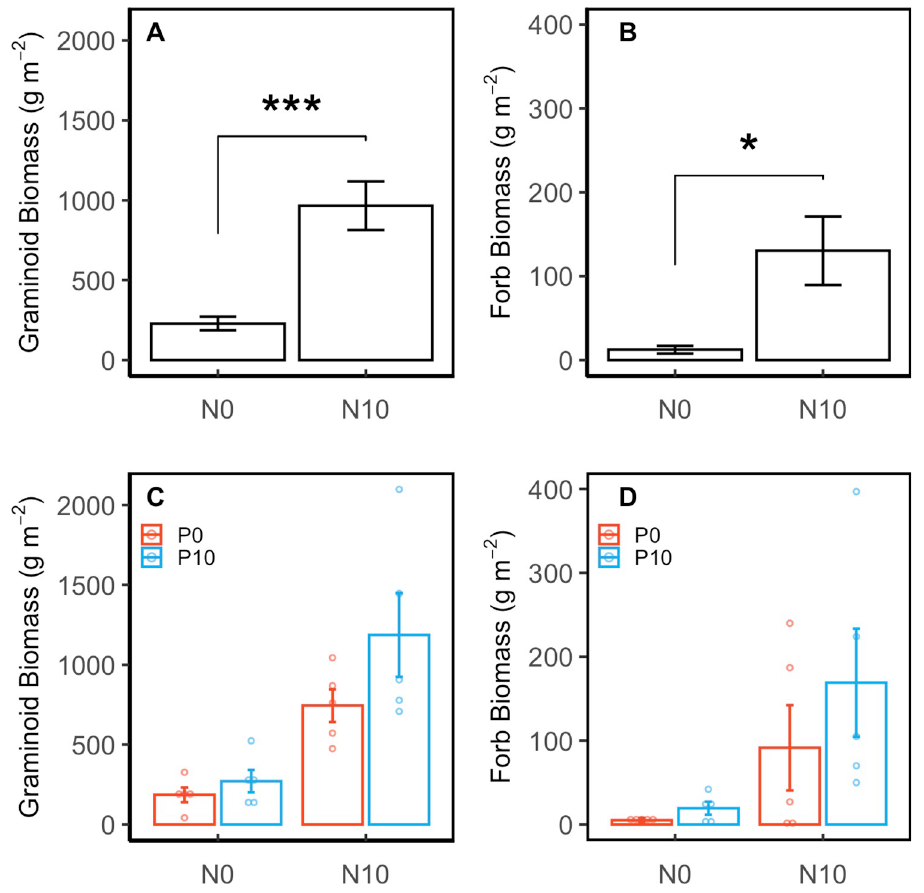
Fig 2. Graminoid and forb biomass production across nutrient enrichment plots. A, B Effect of nitrogen and phosphorus on productivity of graminoid and forb lifeforms in coastal mesic grassland (mean ± SE). Brackets and asterisks indicate significant main effect of N treatments on productivity (‘ � ’ = p -value < 0.05, ‘ ��� ’ = p - value < 0.0001). C, D Effect each nutrient treatment had on productivity of graminoids and forbs (mean ± SE). Hollow points represent productivity values of individual replicates in each treatment. Treatments include control (N0 P0), phosphorus (N0 P10), nitrogen (N10 P0), and nitrogen + phosphorus (N10 P10). Nitrogen treatments are represented on the x-axis while P treatments are represented by color. Scale of the productivity axes are adjusted to improve visualization of variation in the data and are not directly comparable across lifeform